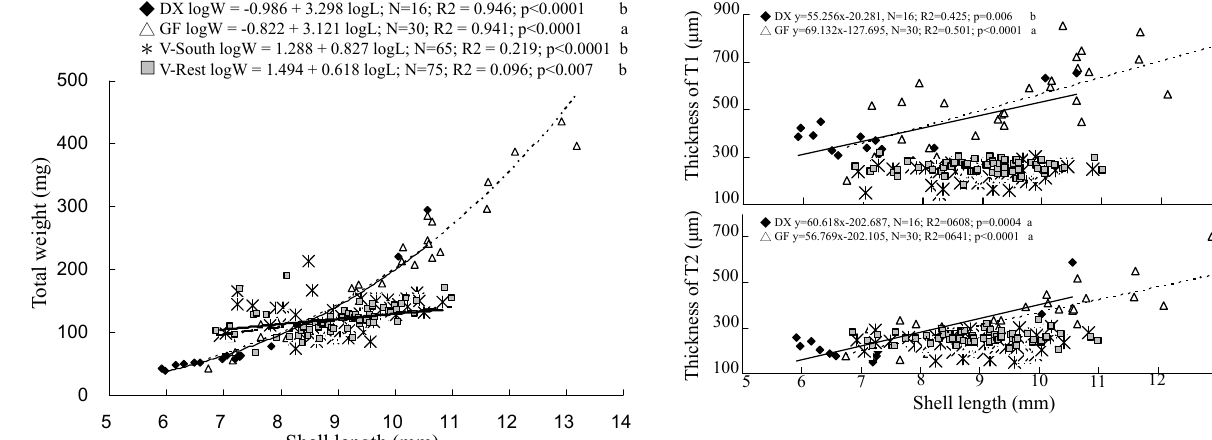
Figure 7. Shell thickness of Anachis and Euplica snails. (a) Thick- ness of body whorl (T1); (b) thickness of penultimate whorl (T2). *: V-South; (cid:3) : V-Rest; different letters following the values in the leg- ends indicate that the regression lines differ significantly ( p